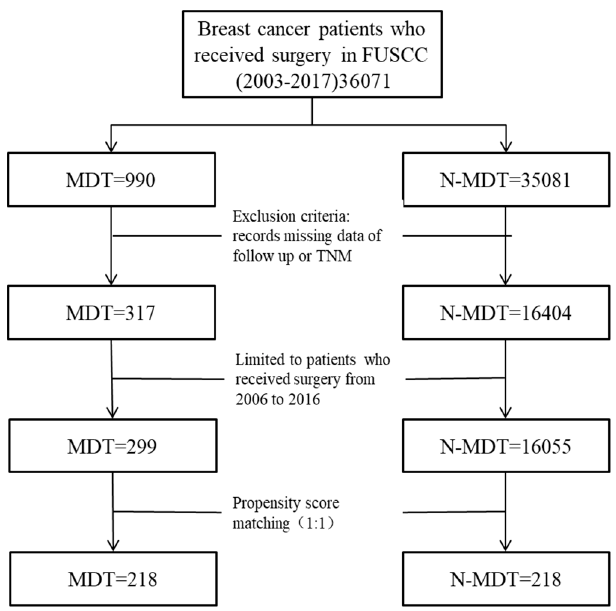
Figure 1. Study flow chart. MDT: Multidisciplinary teams; N-MDT: without multidisciplinary teams’ treatment.